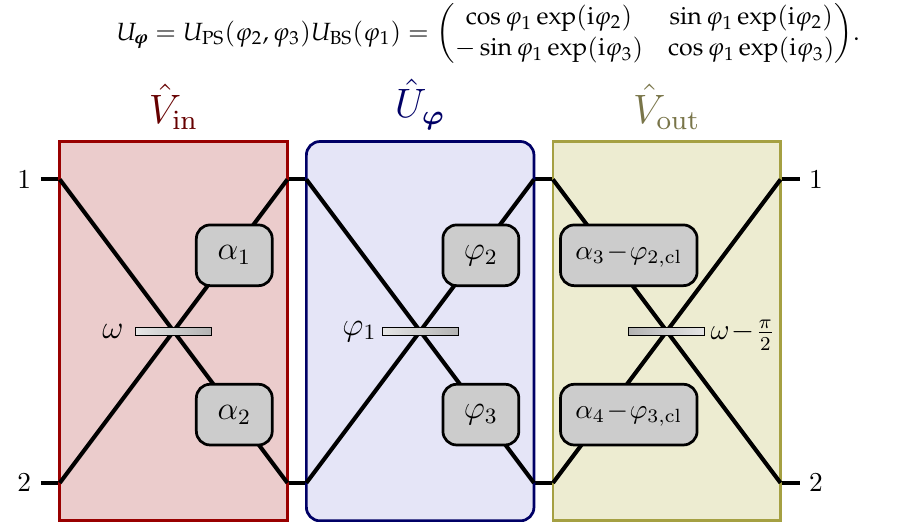
Figure 4. A 2-channel example of a network which allows to estimate at the Heisenberg limit certain functions of the reflectivity ϕ 1 of a beam-splitter and the magnitudes ϕ 2/3 of phase-shifts [37]. The form of the function can be manipulated by changing the values of the arbitrary parameters α , with α 1 α 2 = α 4 α 3 = ∆ α (see Equation (46)), while the value of ω is shown in Equation (43). Similarly − − to the setup for the single-parameter model described in Section 2, a classical knowledge ϕ unknown parameters suffices to optimize the